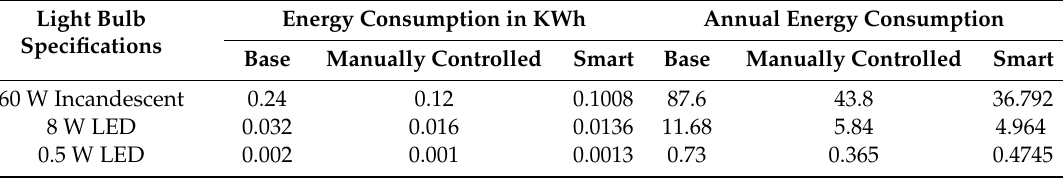
Table 9. Energy consumption in three scenarios.